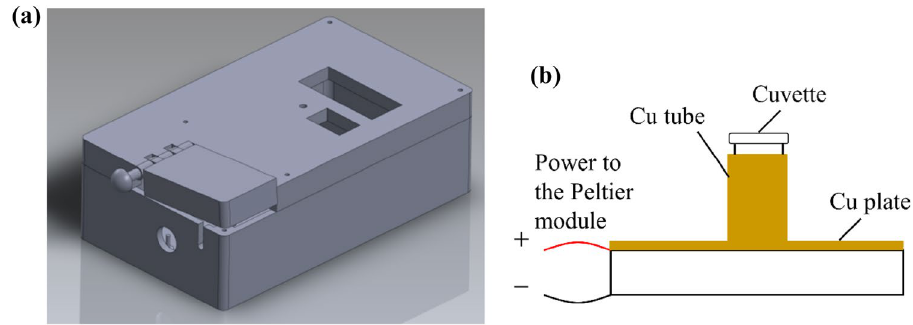
Figure 1. ( a ) 3D design of portable LAMP detection device; ( b ) schematic of cuvette encased by Peltier module.